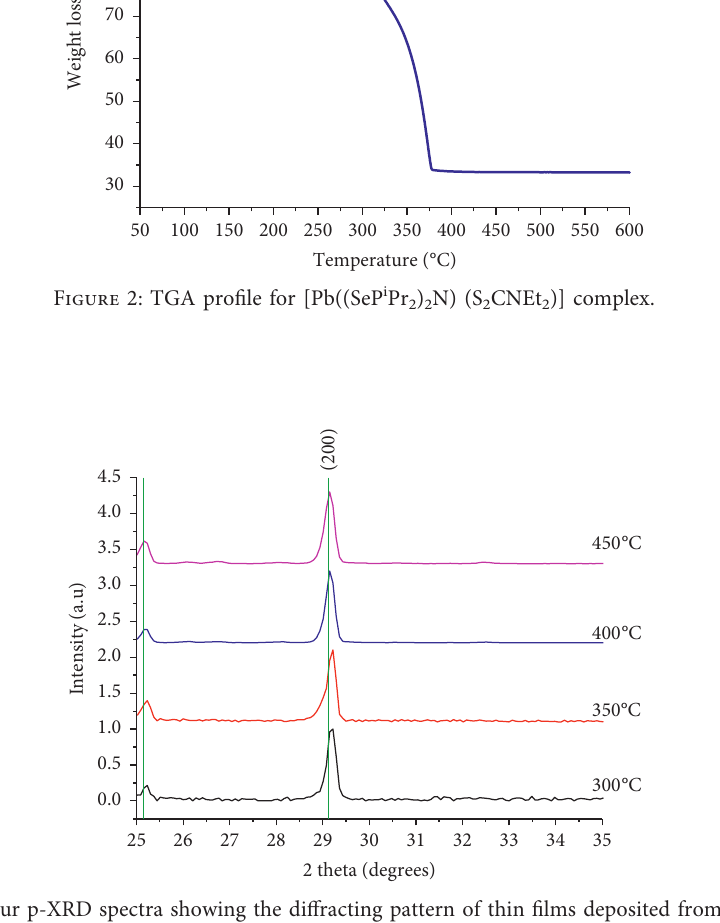
2 ) 2 N(S 2 CNEt 2 )]